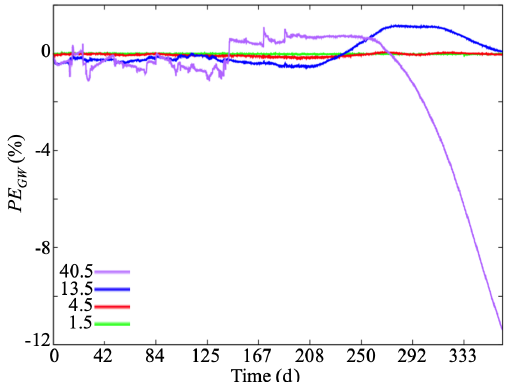
Figure 11. Temporal variations of the percent error of groundwa- ter storage (PE GW ) obtained with meteorological forcing at spatial resolutions of 1.5, 4.5, 13.5, and 40.5km with respect to the highest spatial resolution of meteorological forcing